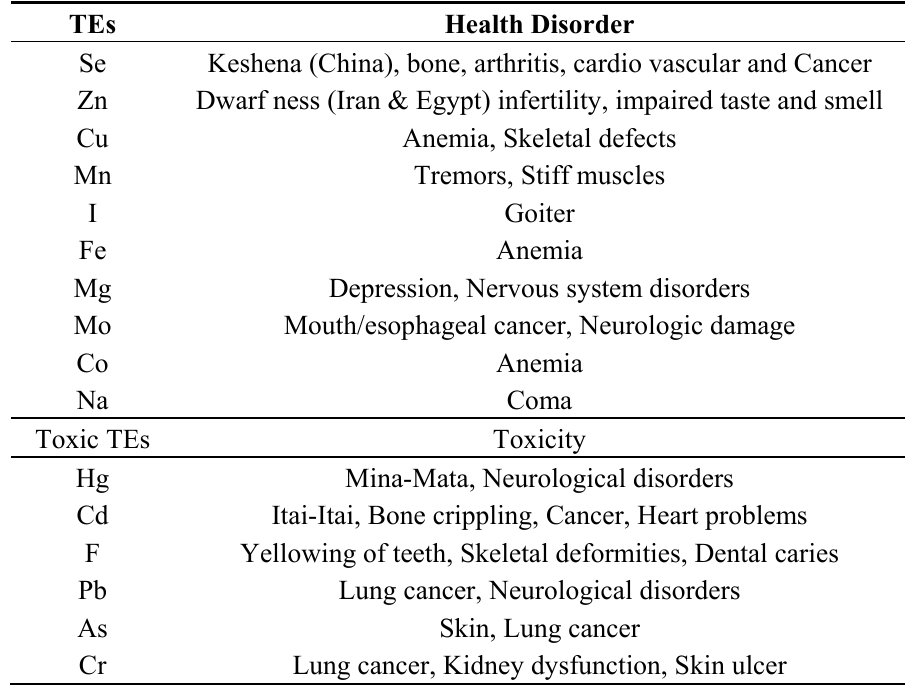
Table 1. Trace elements (TEs) and human